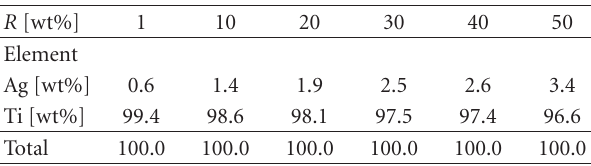
Table 2: Relationship between each element and di ff erent R for Ag- doped TiO 2